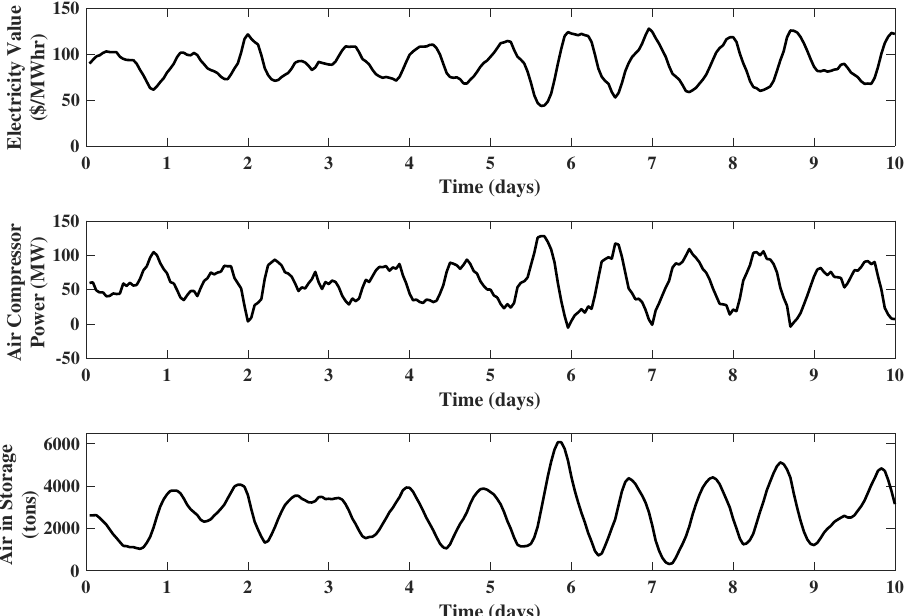
Figure 18. Value of electricity and the resulting air compressor power consumption dispatch for the = ( $20/MW h ) 2 and C = 100 $/ton MeOH with reduced compressors costs. case of Σ C M e